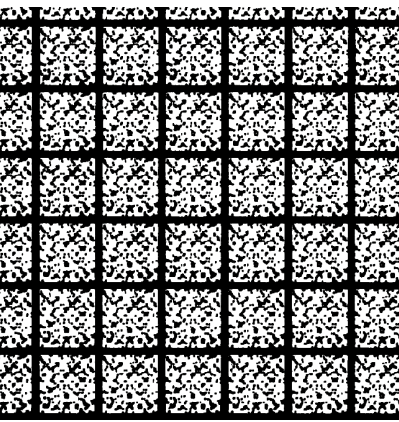
Figure 6. Binarized image of the initial template in Figure 3.